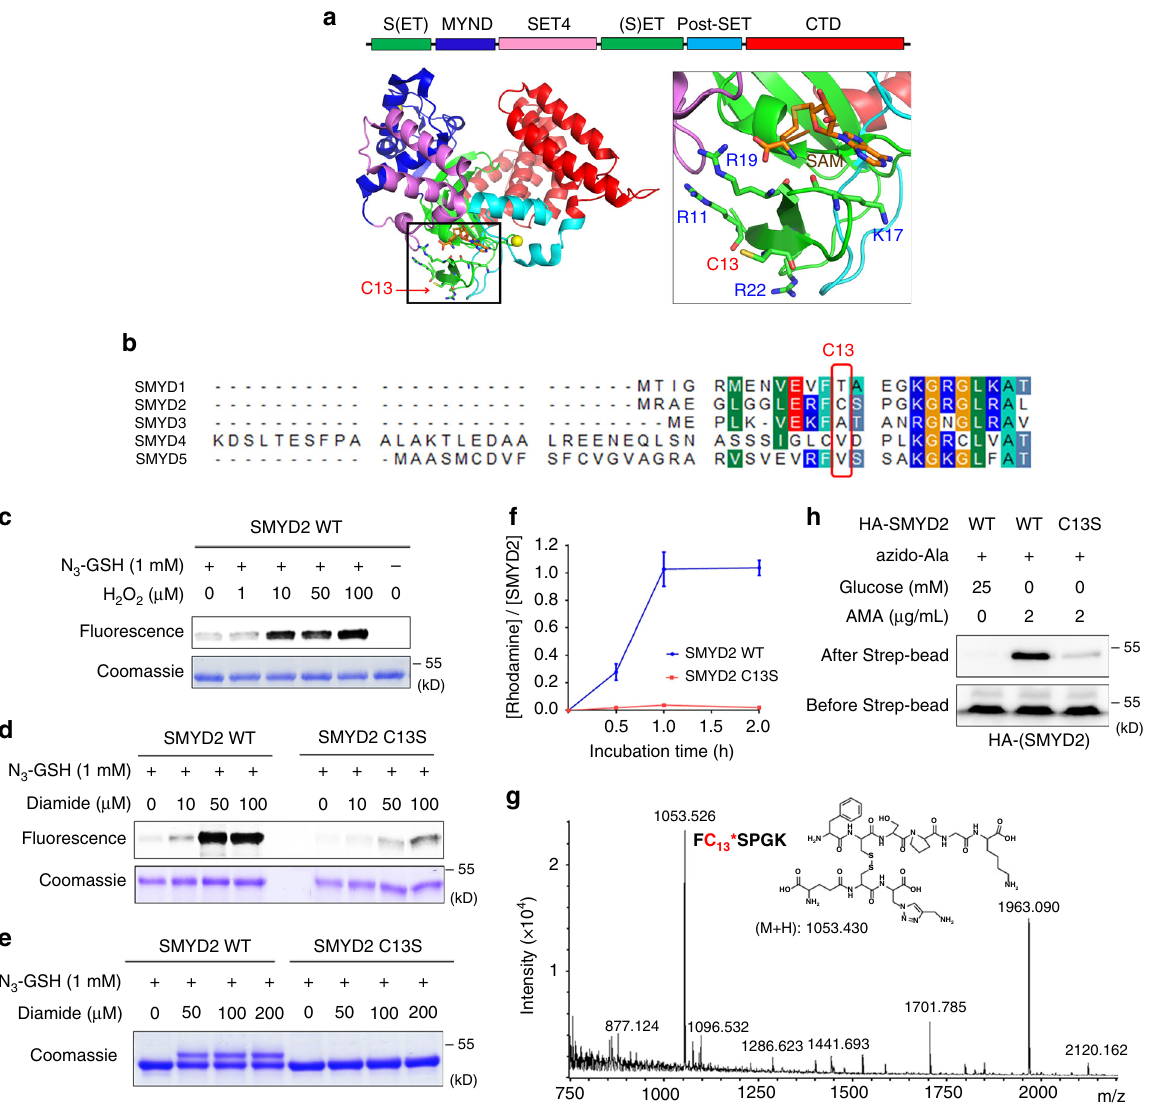
Fig. 2 SMYD2 is selectively glutathionylated at Cys13. a The structure (PDB: 3RIB) and domains of SMYD2, and an enlarged area around Cys13 in SMYD2. b Sequence alignment around Cys13 of SMYD2 with other members of the SMYD family. c – e In-gel analysis of SMYD2 glutathionylation with azido- glutathione. Puri fi ed SMYD2 WT or C13S was mixed with azido-glutathione in vitro and treated with H 2 O 2 or diamide for 15 min. SMYD2 glutathionylation was detected by fl uorescence ( c , d ) or a mass shift ( e ) after click reaction with rhodamine-alkyne or 2-kD PEG-alkyne, respectively. f Quantifying the molar ratio of rhodamine to SMYD2 concentrations after incubation of SMYD2 with oxidized azido-glutathione (N 3 -GSSG-N 3 ) and click reaction with rhodamine- alkyne. Data represent the mean ± SD. g Mass spectrometry analysis of glutathionylated SMYD2. SMYD2 glutathionylated by azido-glutathione was conjugated with biotin-alkyne and digested by trypsin. The digested peptides were enriched by streptavidin-agarose and eluted for MALDI-TOF analysis. h Detection of SMYD2 Cys13 glutathionylation in HEK293 cells stably expressing GS M4 (HEK293/GS M4). After transfection of SMYD2 WT or C13S, cells were incubated with azido-Ala. After inducing glutathionylation, collected lysates were subjected to click reaction with biotin-alkyne before pull- downs with streptavidin-agarose and western blotting. All data are representative of 3 independent